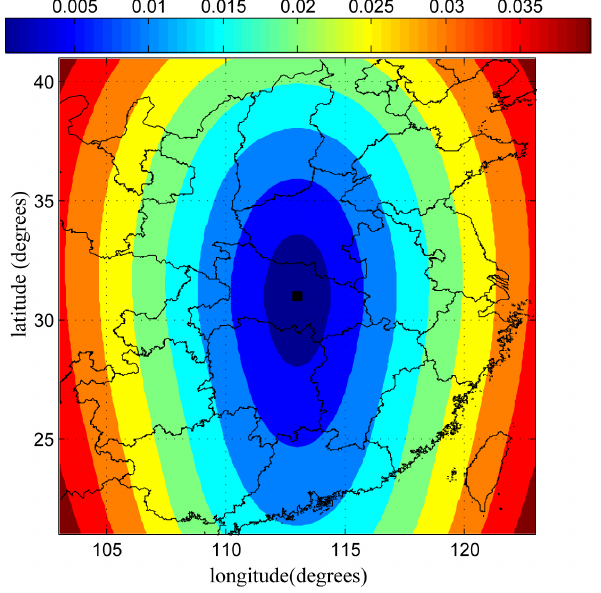
Fig. 5. Same as in Fig. 4 except for the geodesic distance differ- ence between the results obtained by Eq. (36) and forms derived by Sodano (in meter). There difference is below 1cm in a large (blue) area.